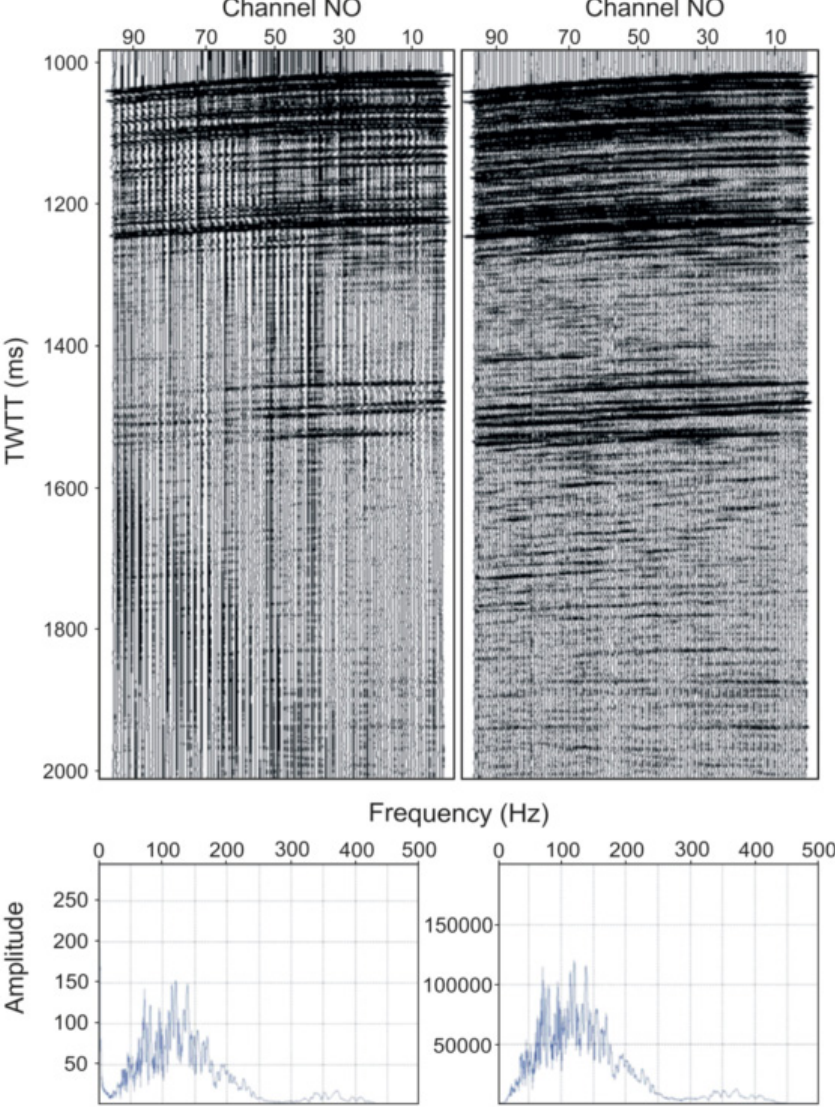
Figure 7. Comparison between raw (left) and filtered (right) shot record (shot point 370, line T_T05_HR) in the time (above) and in the fre- quency (below) domains. After the application of a band-pass filter and a gain function, it is possible to detect the deeper reflectors and to appreciate that the low frequency noise component (between 0 and 10 Hz) has been removed from the spectrum. However, the spectra ab- solute values are not directly comparable because a gain function is present in the pre-processed